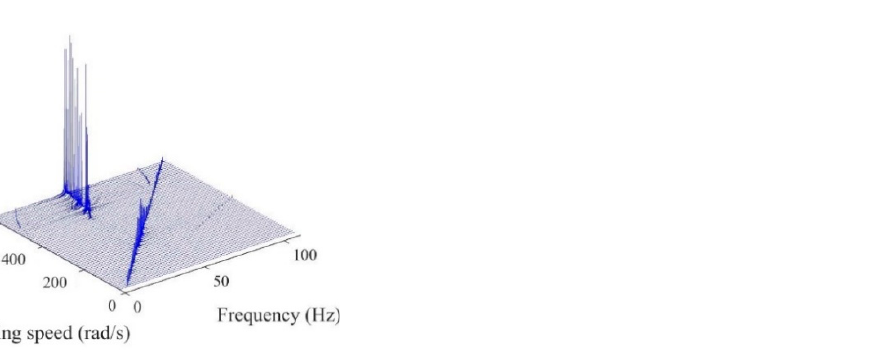
Figure 18. Frequency waterfall chart of the rotating disk along a vertical direction at oil pressure of 1.2 MPa.